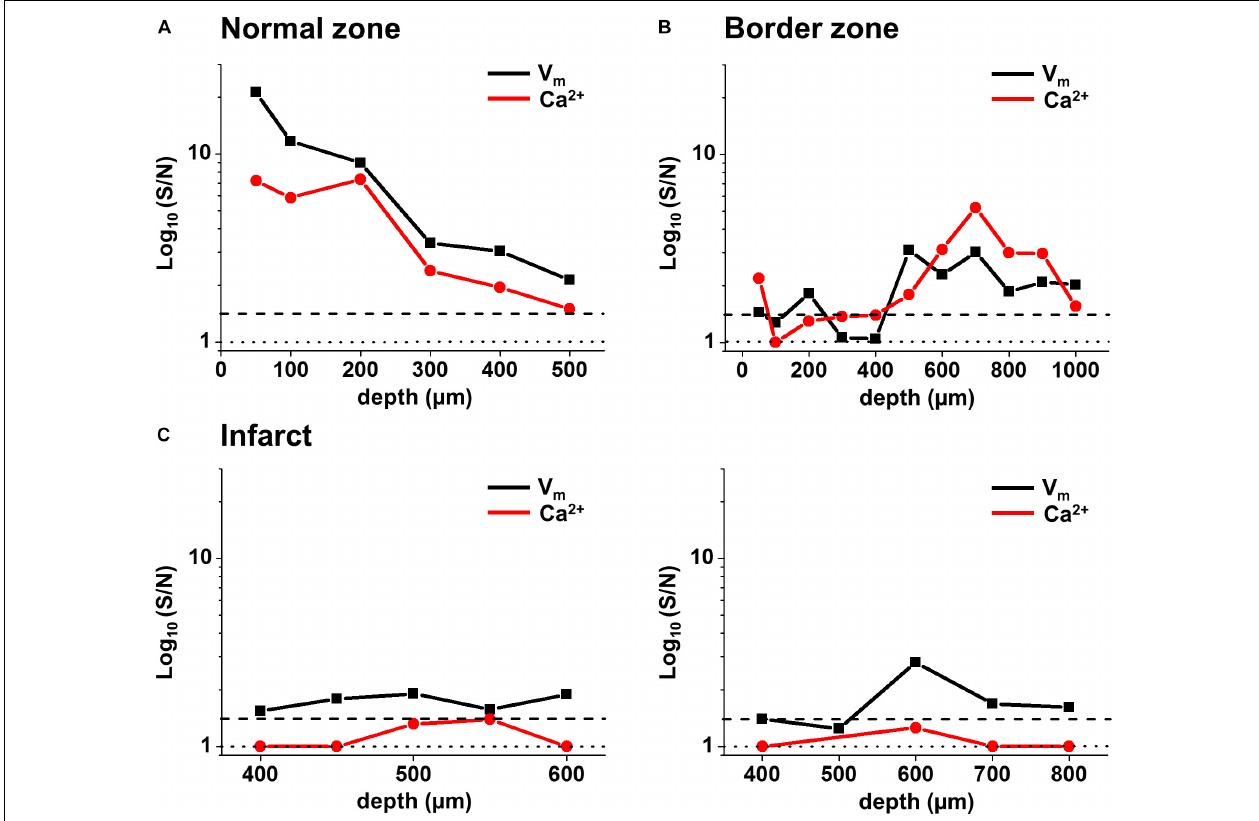
FIGURE 7 | Voltage and Ca 2 + signal-to-noise in the normal zone (NZ), border zone (BZ), and infarct zone (IZ) from individual hearts. Voltage (black) and Ca 2 + (red) S/N were plotted through depth for individual hearts in (A) NZ, (B) BZ, and (C) IZ. S/N in the IZ for two hearts [left and right panels in (C) ] were plotted between depths where a voltage signal was detected. S/N values of 1 (no distinguishable signal) are illustrated by the dotted line. S/N values of 1.4 (indicating a real signal) are illustrated by the dashed